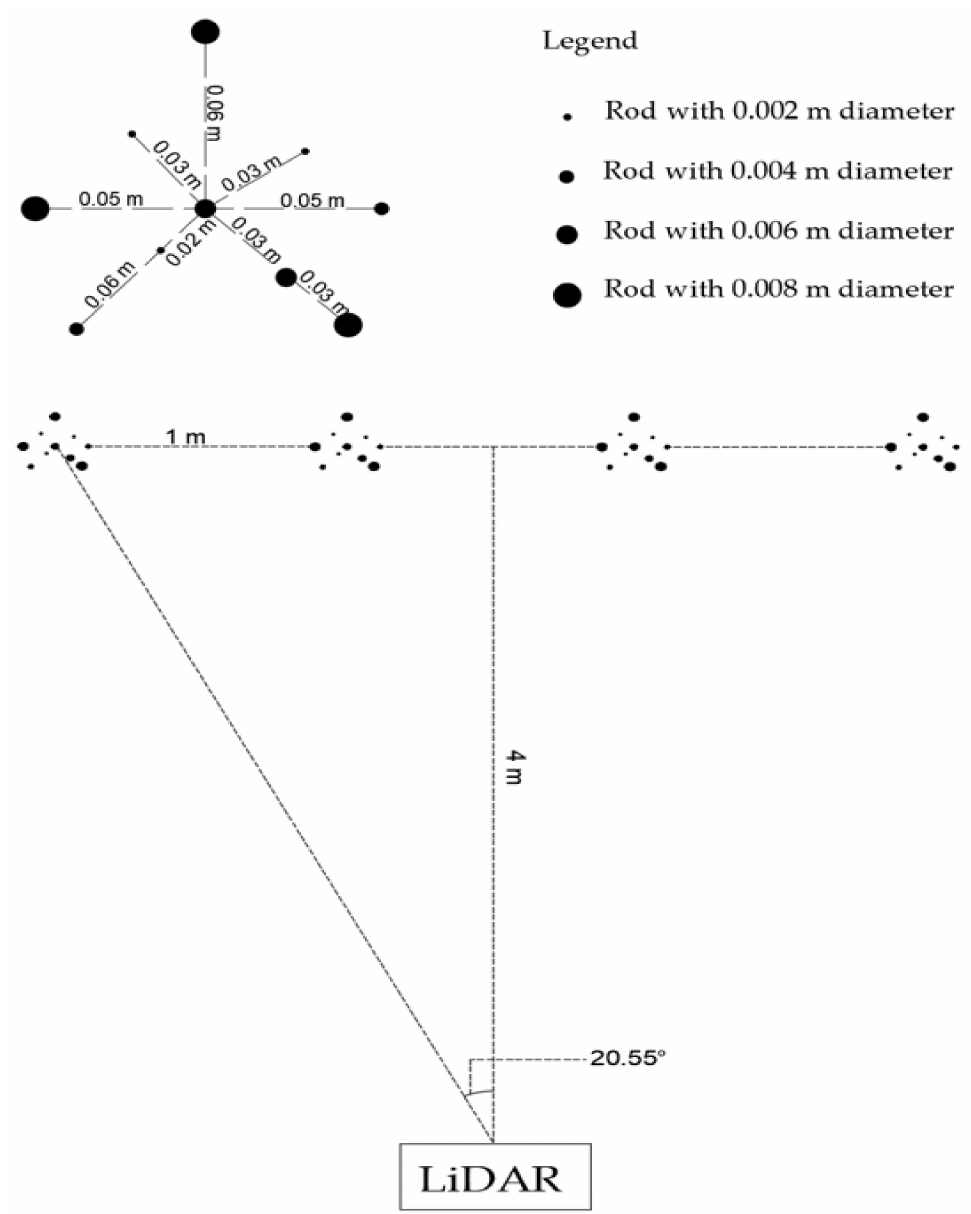
Figure 2. Bird’s-eye view of the group of rods trial setup. One group of rods formed a geometrical shape and rods were at the same height with different diameters. Black dots are symbols to show rod diameters. The LiDAR was placed at 4 m distance from the groups of rods and the view angle of the outermost groups of rods was 20.55 on either side of the centre